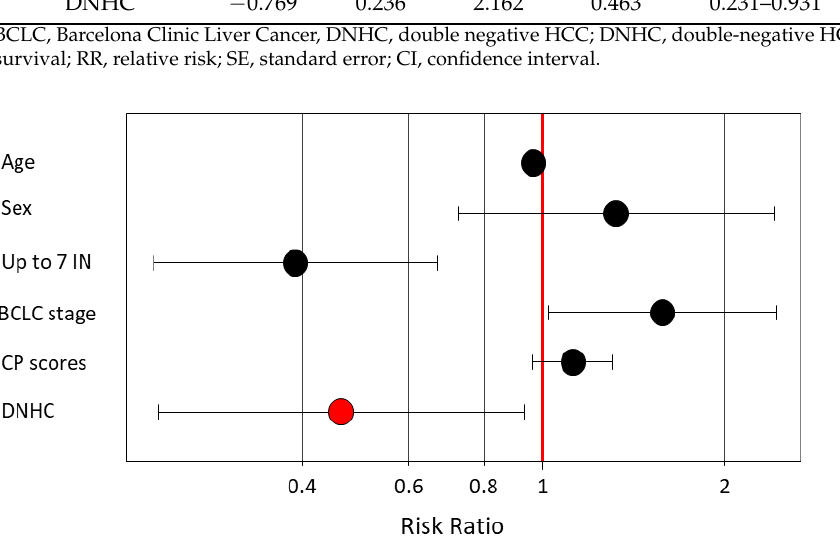
Figure 6. Multivariate analysis for factors that were associated with the OS of higher-stage HCC. Age, BCLC-stage, and Child–Pugh scores increased RR. Up to 7 criteria IN and DNHC decreased the RR. BCLC, Barcelona Clinic Liver Cancer; CP, Child–Pugh; DNHC, double negative